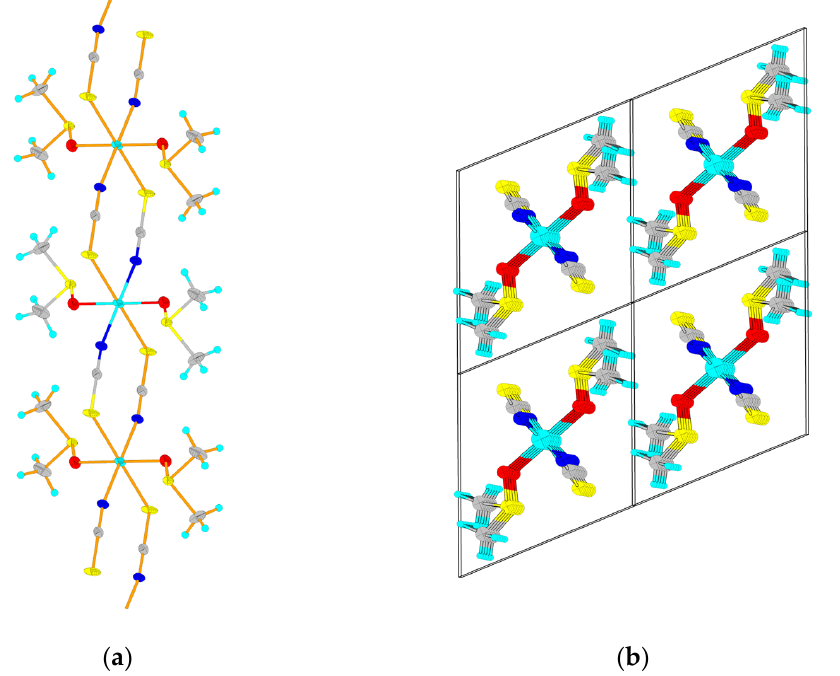
Figure 6. The crystal structure of 4 . ( a ) Infinite chains running along 100 crystallographic directions; ( b ) packing of above chains.